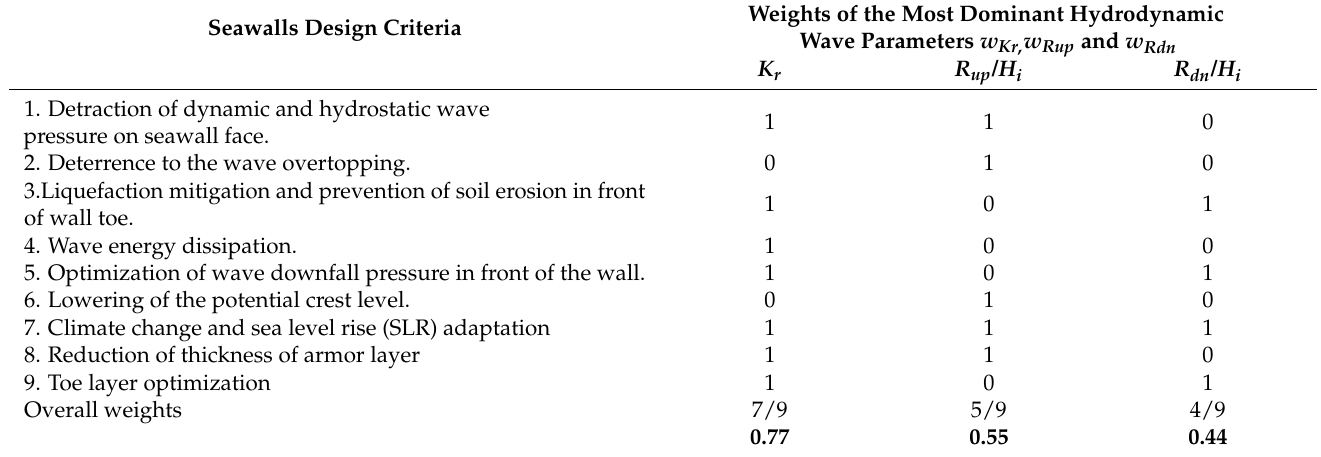
Table 7. Weights for normalized hydrodynamic performance parameters.